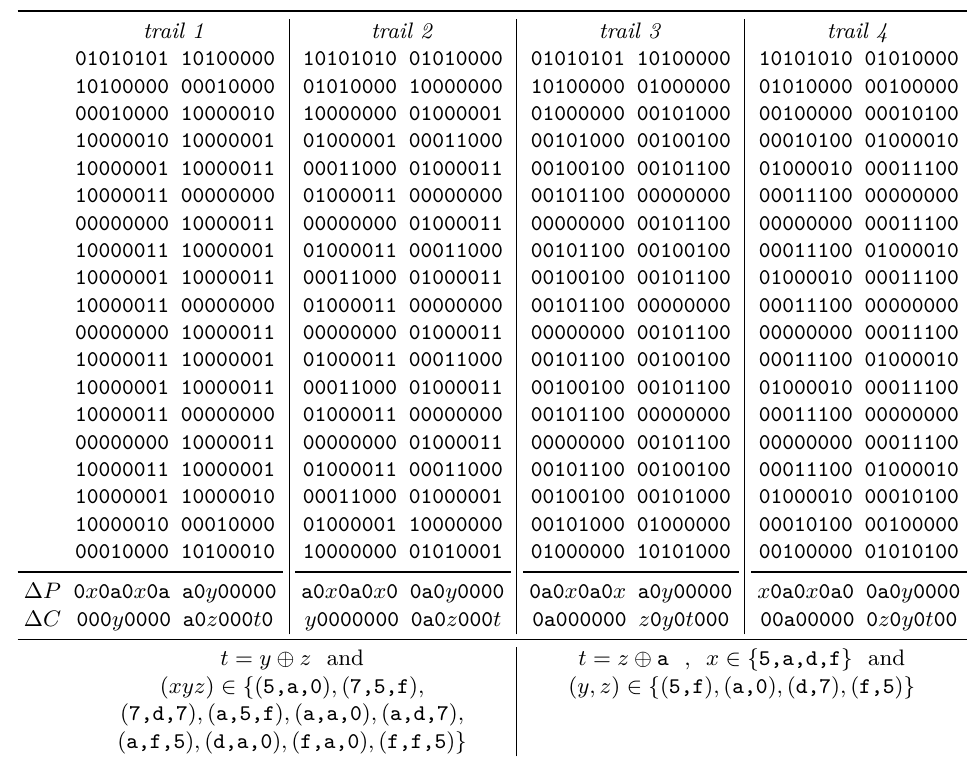
Table 3: 18-round differentials with the highest EDP (= 2 − 58 . 11 ) within the differentials of the activity patterns with the minimum number of active S-boxes (=